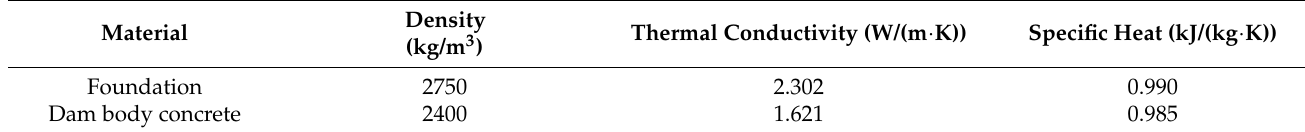
Figure 9. The location of the joint meters inside the dam.